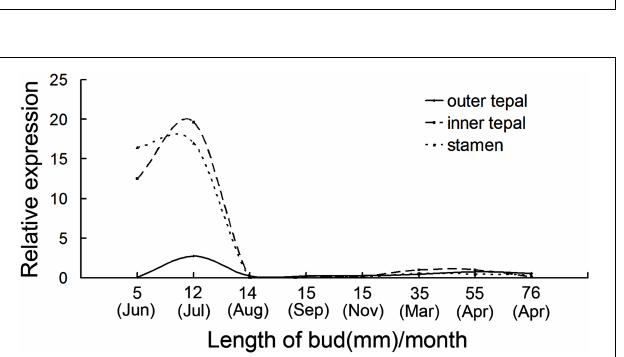
FIGURE 3 | Semi-quantitative PCR analysis of the MAwuPI expression pattern in Magnolia wufengensis . For this assay, flower buds, and juvenile leaves were collected from M. wufengensis growing in the secondary natural forest. The flower buds were separated into outer-tepals, inner-tepals, stamens, and carpels, and frozen immediately in liquid nitrogen. Three biological replicates were performed for each sample. le, leaf; te, tepal; st, stamen; ca, carple; actin as internal control.